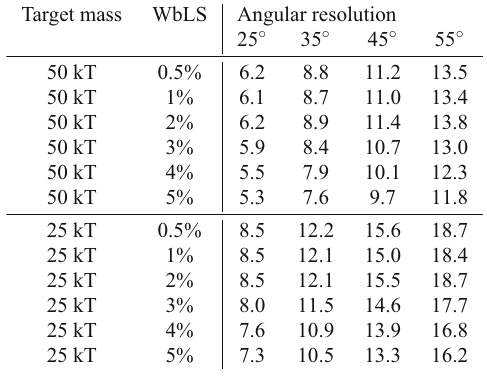
and the baseline background assumptions